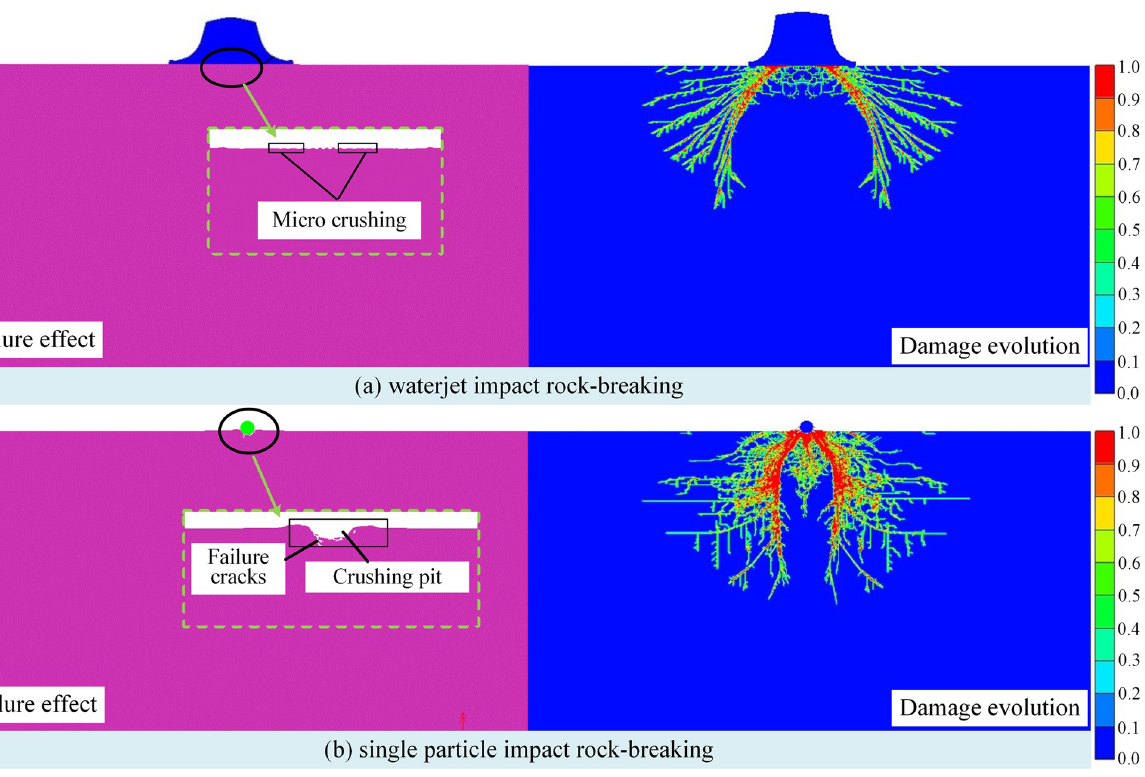
Fig 6. The rock-breaking effect under waterjet impact and particle impact.